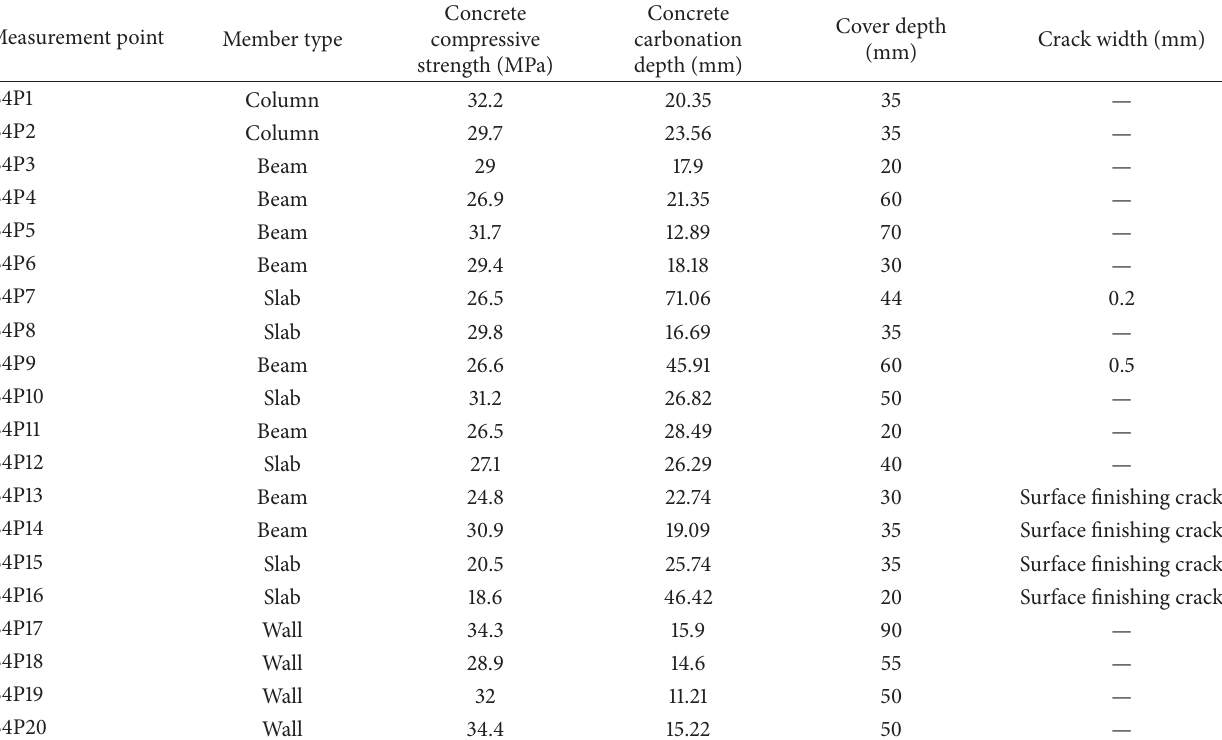
Table 6: Field investigation data (Building 4, construction completion year: